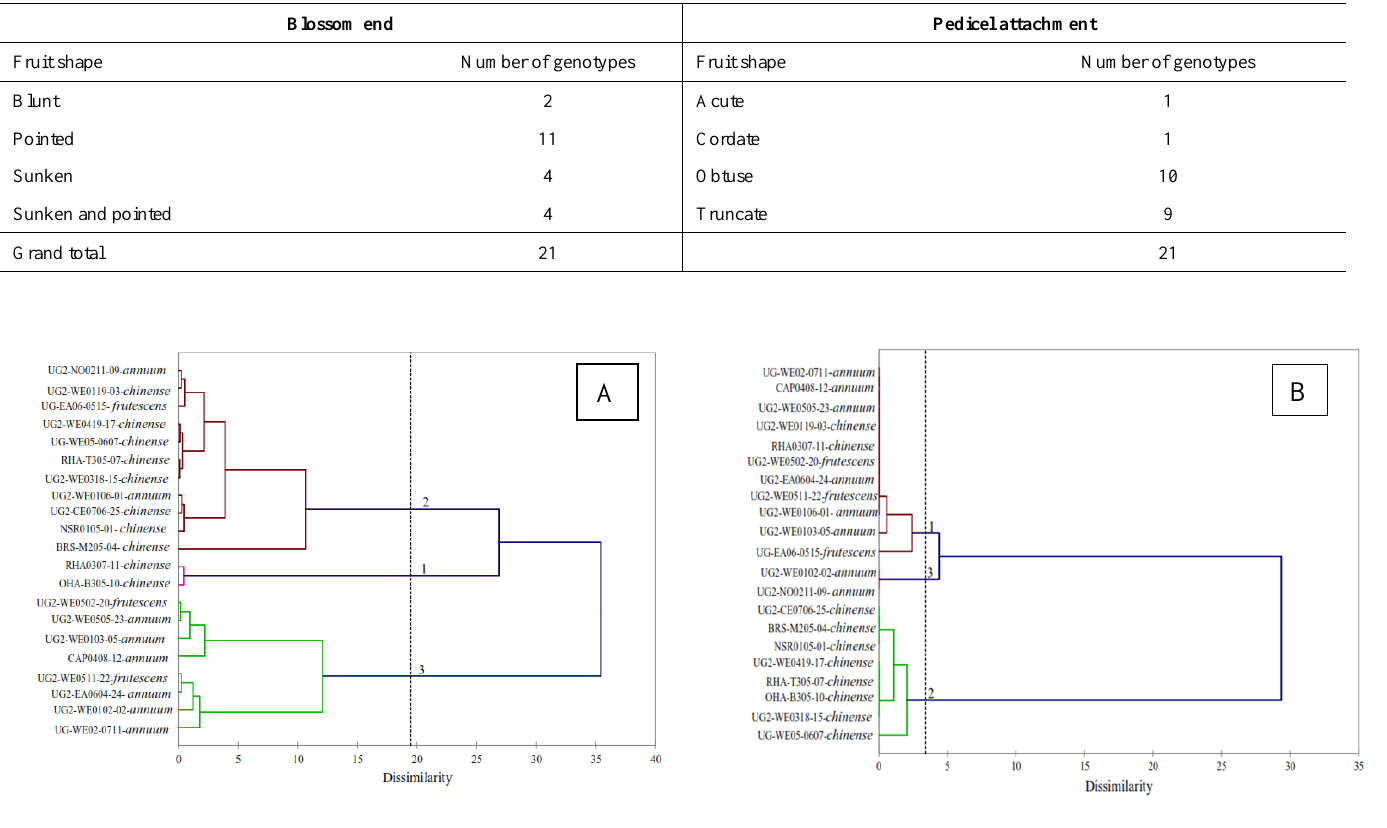
Table 3 . Distribution of variations in Capsicum fruit shape at blossom end and pedicel attachment